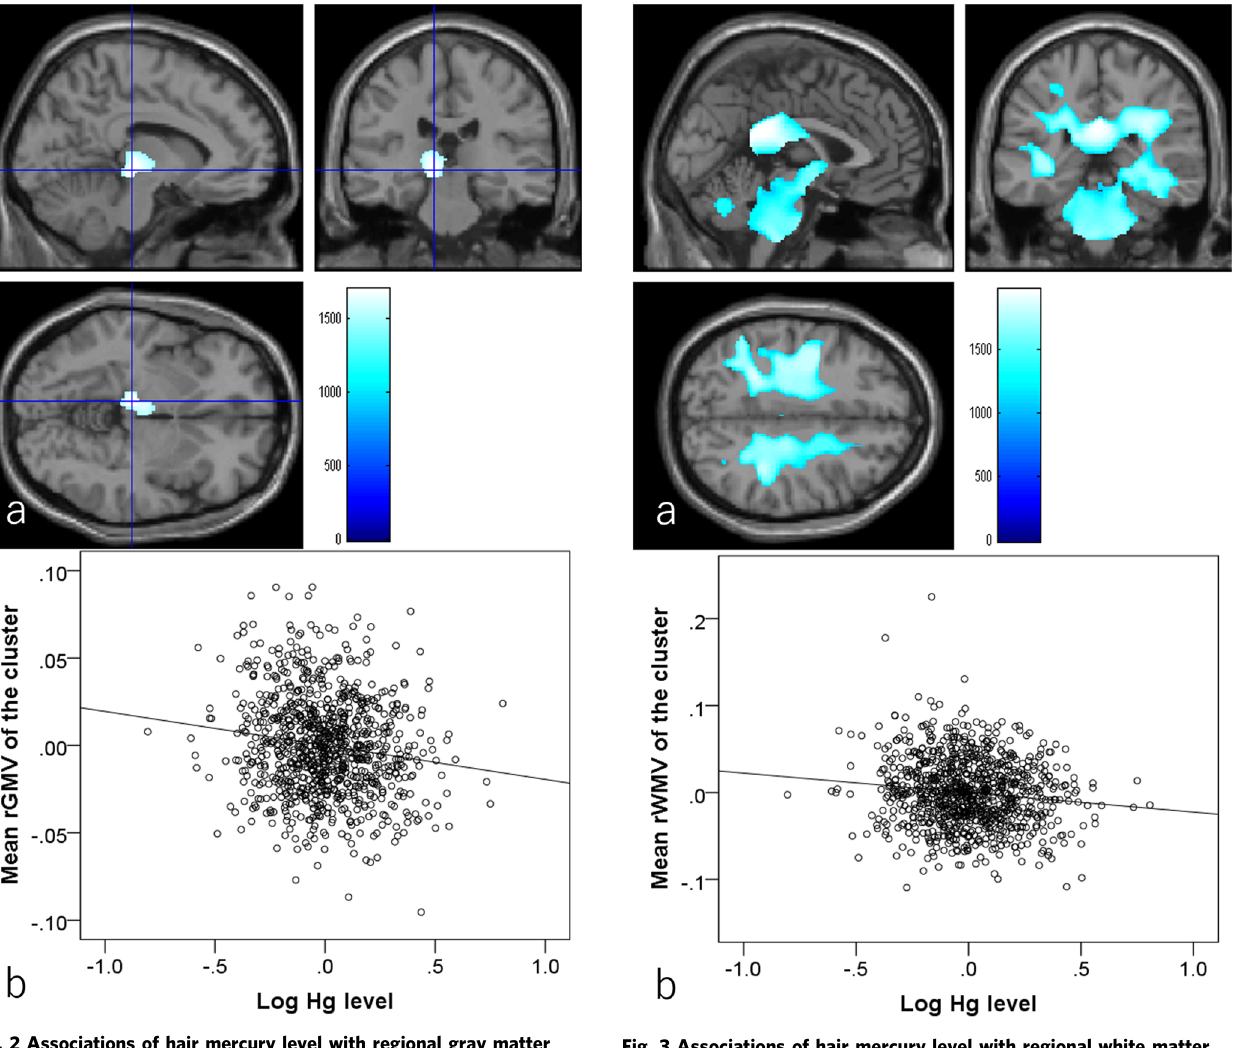
Fig. 3 Associations of hair mercury level with regional white matter volume (rWMV)( N = 920). Greater hair mercury level was signi fi cantly associated with lower rWMV in widespread white matter areas. Colored bars indicate TFCE scores. TFCE score is unit-free and re fl ects both voxel ’ s height and the sum of the spatially contiguous voxels supporting it; therefore, it re fl ects both the strength and extent of effects. All results are overlaid on a “ single-subject T1 ” SPM8 image. a Regions with signi fi cant results. The results shown were obtained using a threshold P < 0.05, corrected for multiple comparisons based on 5000 permutations using the TFCE score. b A partial residual plot with the trend line depicting the associations between residuals of mean rWMV in the largest signi fi cant cluster and the residuals of the logarithms of hair mercury levels with other confounding factors Associations between hair Hg levels and FA . Whole-brain multiple regression analysis controlling for the same variables as in psy- chological analyses showed that higher hair Hg level was asso- ciated with greater FA in an anatomical cluster spread across the left internal capsule, left posterior corona radiata, left posterior thalamic radiation, left superior longitudinal fasciculus, and left tapetum, another anatomical cluster spread across the right internal capsule, right superior corona radiata, right posterior corona radiata, right posterior thalamic radiation, right external capsule, and right superior longitudinal fasciculus, and a third anatomical cluster spread across the splenium of the corpus